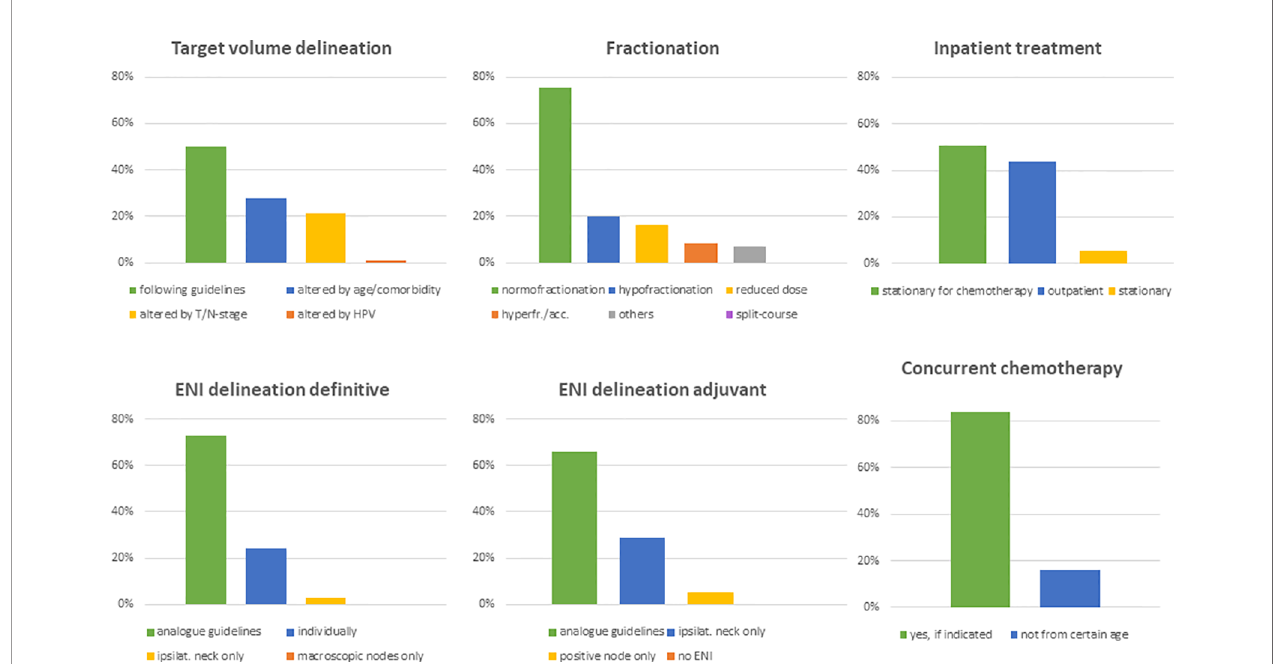
FIGURE 4 | Bar charts indicating alteration of target volumes (n=130), fractionation schemes (n=130), treatment modality (n=130), elective nodal volumes in the de fi nitive (n=129) and adjuvant setting (n=129) as well as the application of concomitant chemotherapy in elderly HNSCC patients (n=129). (ENI, elective nodal